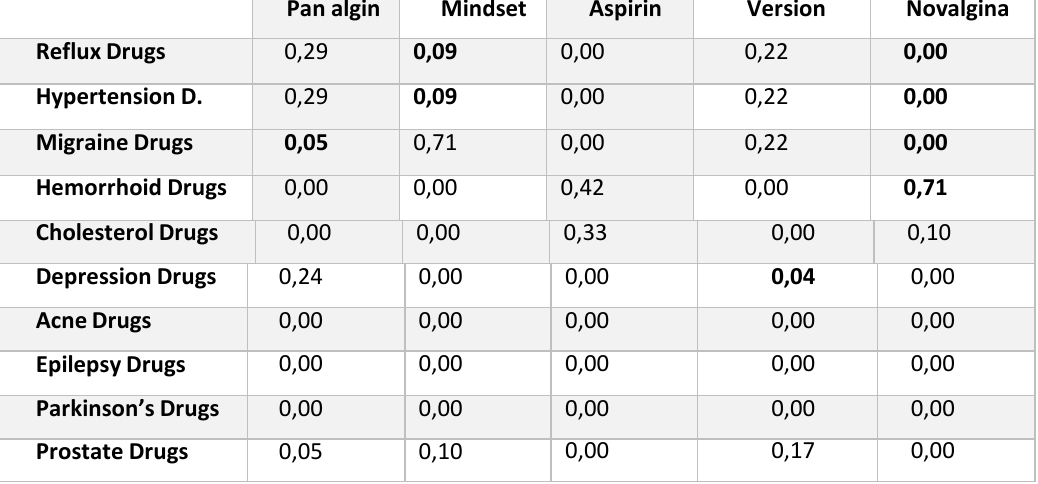
Table 7. The Estimated values for painkiller Drugs concerning Jaccard Pan